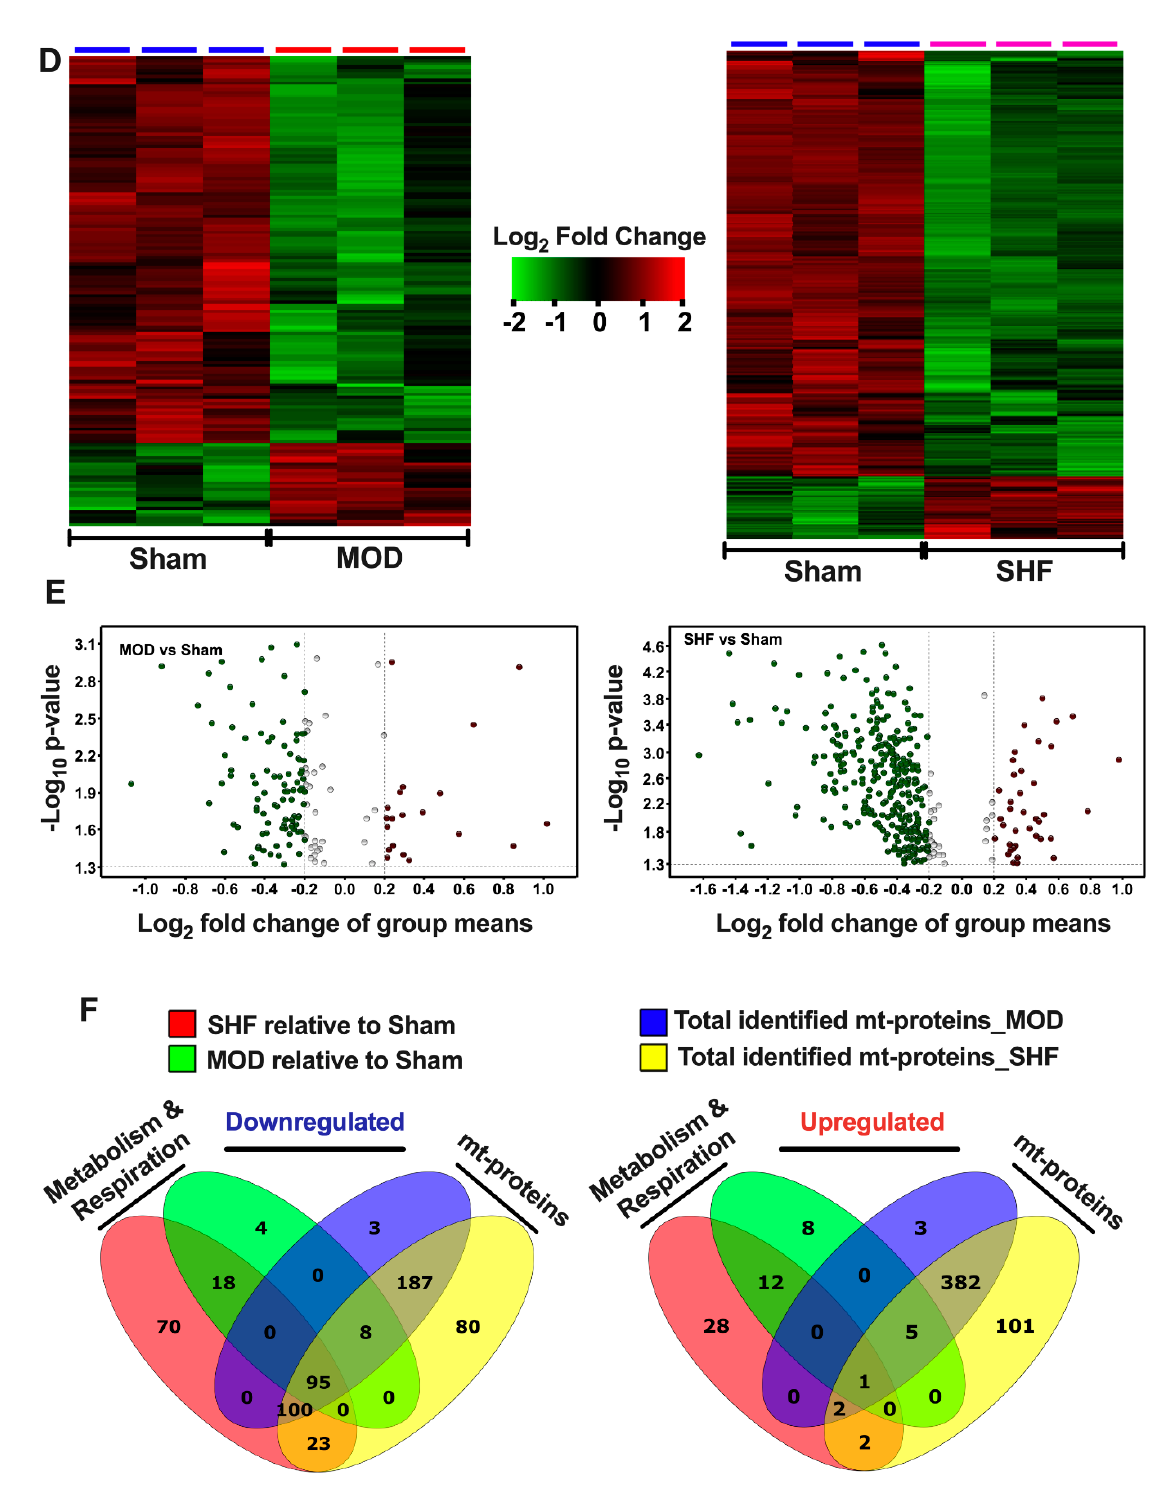
Figure 1. Visualization of the MOD and SHF proteomic datasets. ( A ) Heat maps showing differential log 2 fold change in expression of identified proteins that changed in MOD vs. Sham (left), and in SHF vs. Sham (right). The same Sham biological samples were used as a reference for both TMT-label proteomic runs; n = 3 biological samples per group. ( B ) Volcano plots of the identified proteins that changed in MOD (left) and SHF (right) groups vs. Sham. The x -axis displays the log 2 fold change in group means for down-regulated proteins (green) and up-regulated proteins (red) in MOD or SHF vs. Sham. The y -axis displays the -Log 10 p -value of identified proteins that were statistically significant in MOD (left) and SHF (right) vs. Sham. A -Log 10 p -value cutoff of 1.3 ( p = 0.05) and higher was considered significant. ( C ) Venn diagrams showing the number of identified pro-